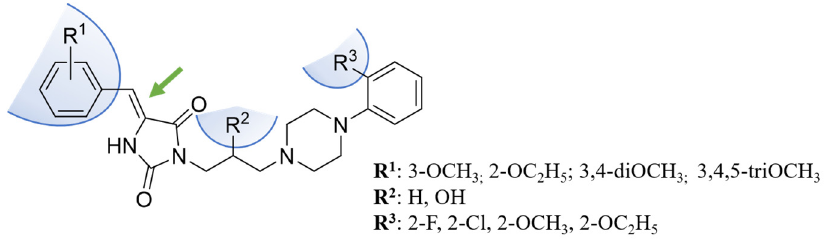
Figure 4. The herein investigated chemical